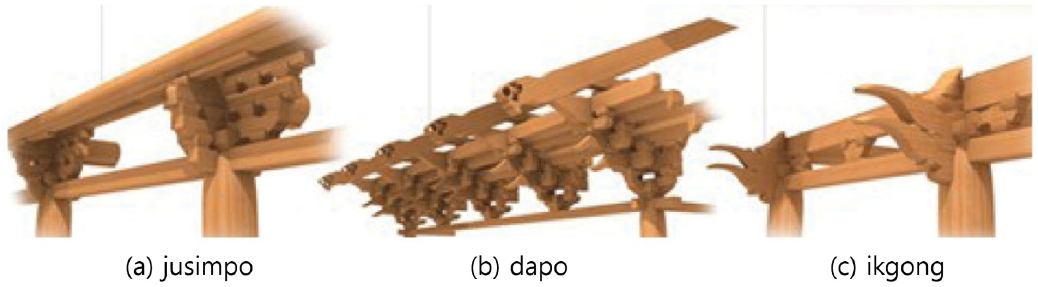
Figure 13. Types of the Gongpo (bracket): ( a – c ) (Source: Doopedia by Doosan Corporation).